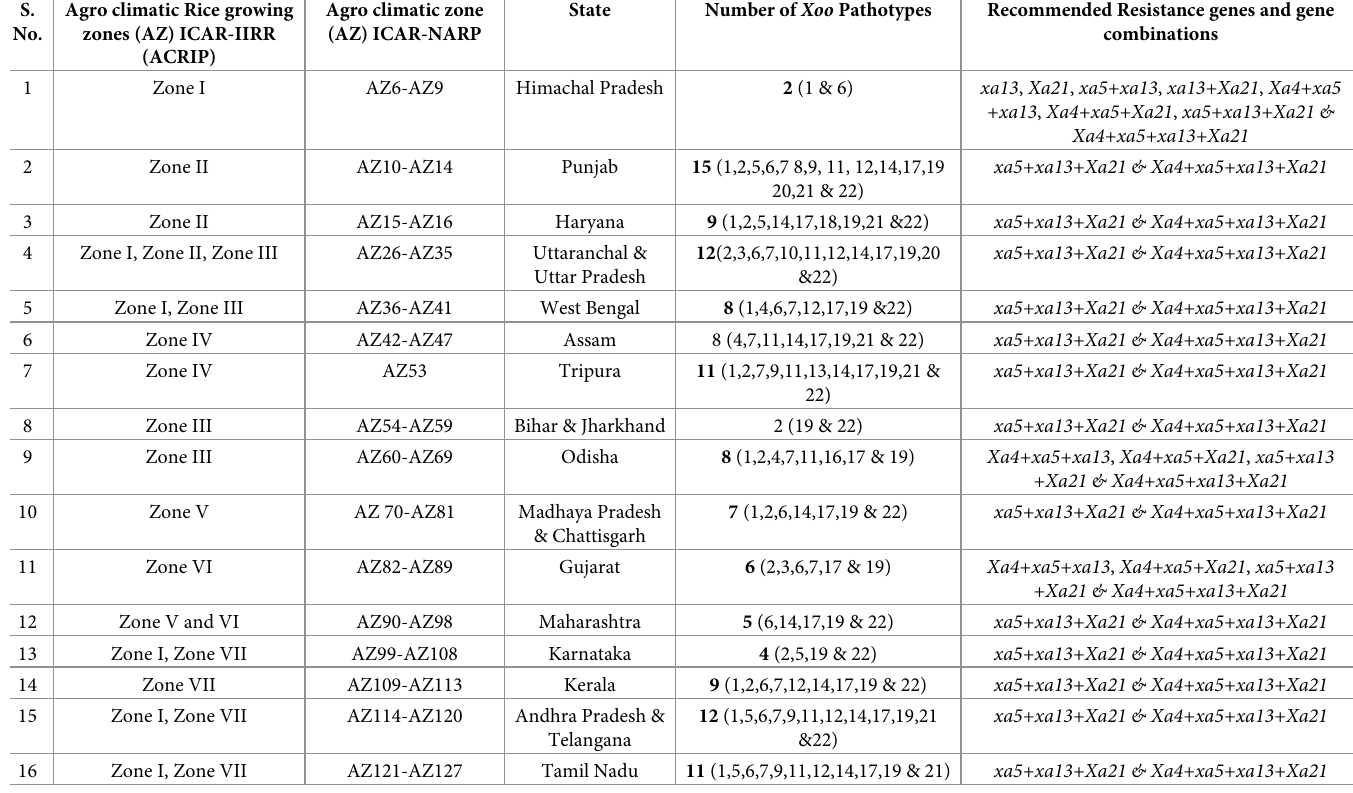
Table 1. Agroclimatic zones according ICAR- IIRR [4] and ICAR-NARP [20], existing pathotypes and recommended genes. S. Agro climatic Rice growing No. zones (AZ)